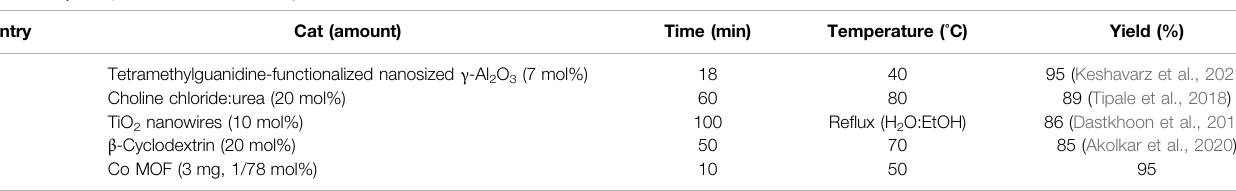
TABLE 4 | Comparison of different catalysts in